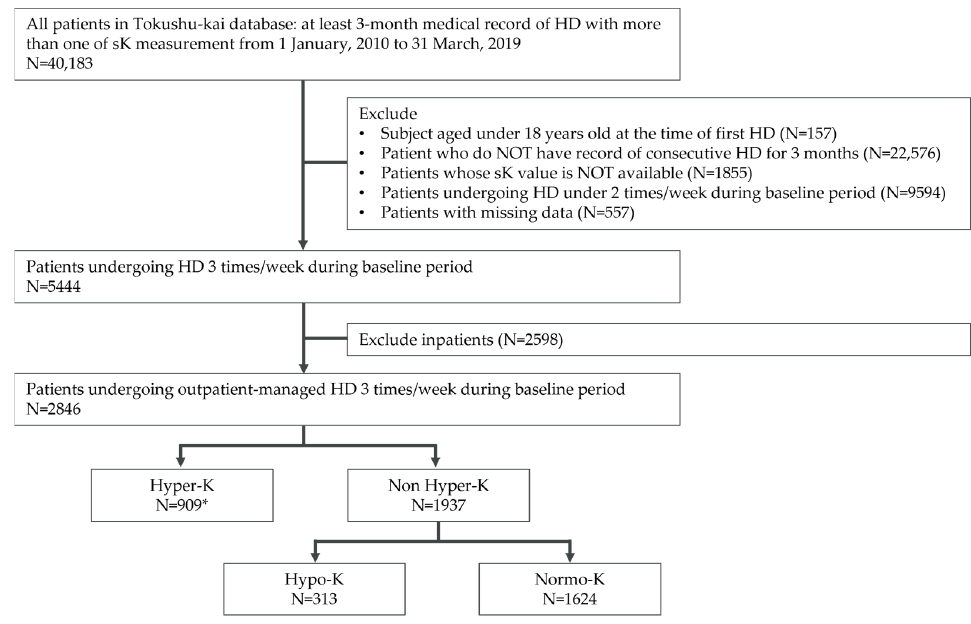
Figure 1. Flow diagram of patient inclusion in the study. Abbreviations: HD—hemodialysis; sK—serum potassium * Hyper-K group includes patients with both hyperkalemia and hypokalemia ( n = 20).